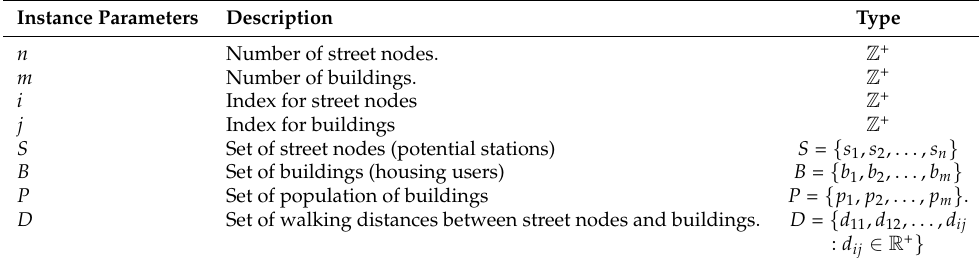
Table 2. FPP instance parameters.